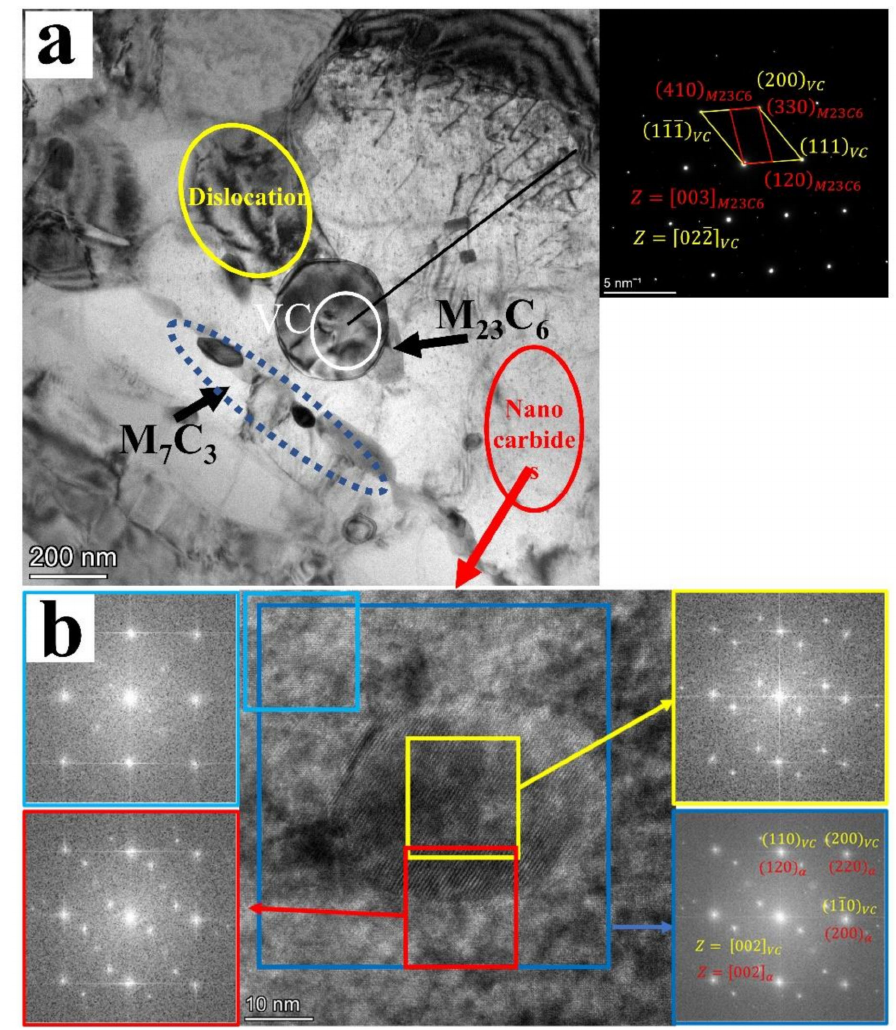
Figure 8. ( a ) Distribution of the precipitated phase in the tempered martensite; ( b ) High-resolution and Fourier change images of the selected area of nano VC in